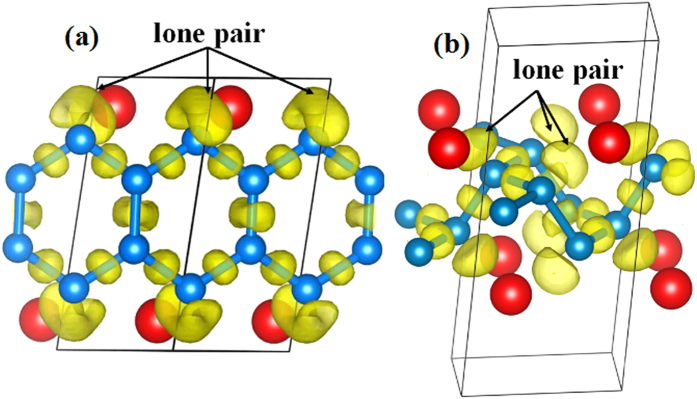
ELF isosurface (value = 0.8) illustrated on a plane containing C6 rings in BeC2.(a) α-phase and (b) β-phase.